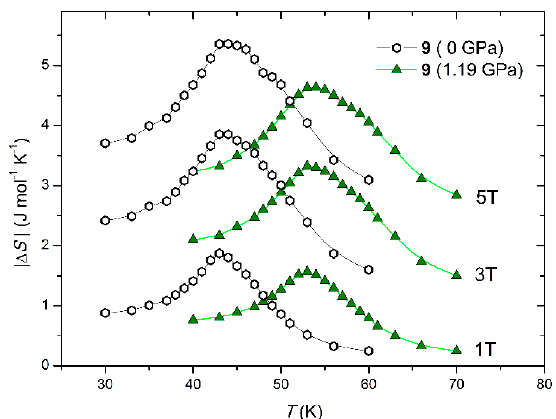
Figure 25. Temperature dependence of the magnetic entropy change of as-synthetized sample 9 ( p = 0 GPa) (empty symbols) and 9 under pressure p = 1.19 GPa (filled symbols) determined for µ 0 ∆ H = 1, 3 and 5